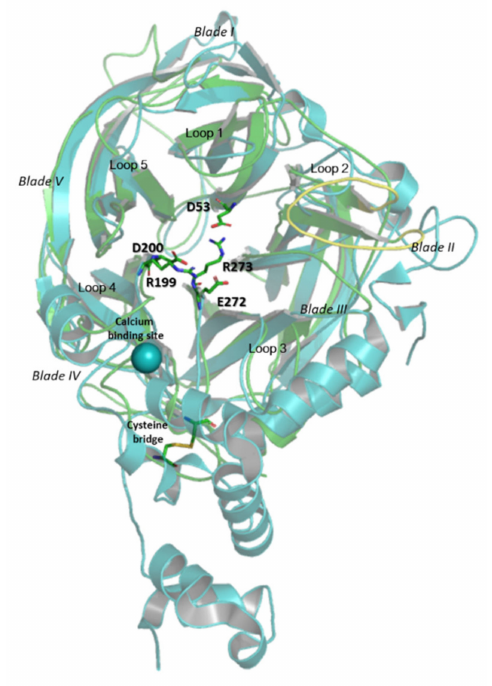
Figure 6. Hmc Isc inulosucrase model (green) overlapped with the crystal structure of L. johnsonii inulosucrase (2YFR; blue). The root-mean-square deviation (RMSD) between the two structures is 3.839. Loops and blades are indicated, and active site amino acid residues are highlighted. The special Loop 2 in Blade II in Hmc Isc is indicated in yellow. Hmc Isc shows a disulfide bridge while 2YFR shows a Ca 2+ binding